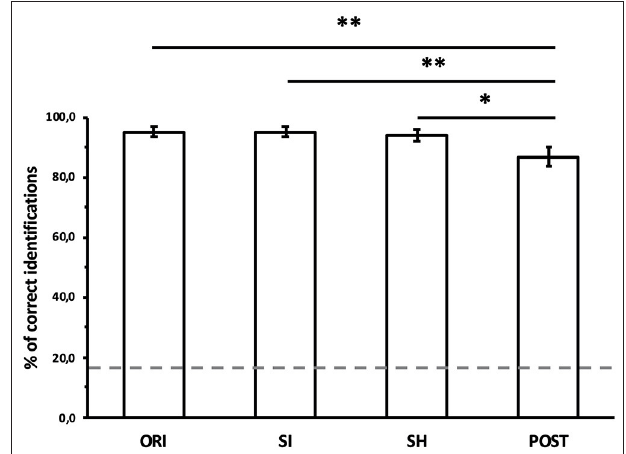
FIGURE 4 | Average correct identifications of the model, as a function of the normalizations of structural features. ORI, original motion; SI, size-normalized; SH, shape-normalized; POST, posture-normalized. Dashed horizontal line indicates the chance level. Error bars indicate SE. Significant differences between normalizations: * p < 0.05, ** p <